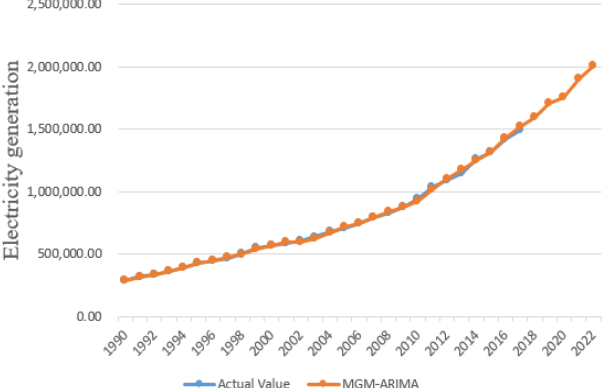
Figure 13. The degree of coincidence between the actual power generation in India and the predicted power generation of the MGM-ARIMA.